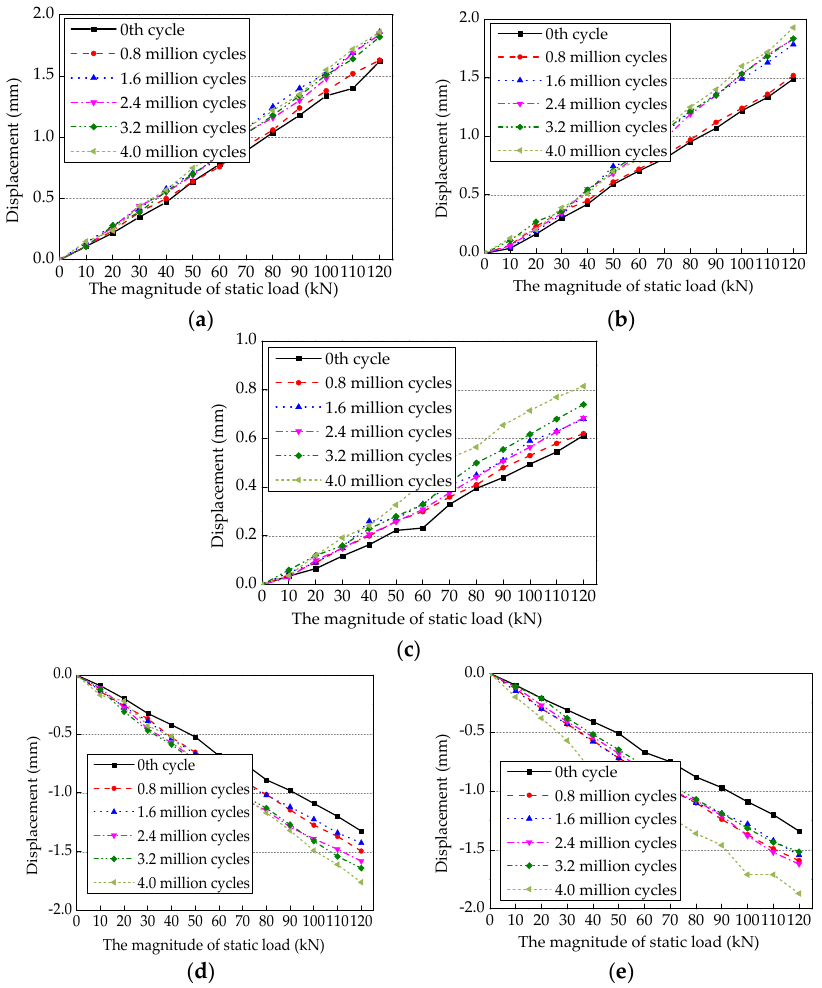
Figure 9. Effect of fatigue cycles on static load—displacement curves. ( a ) Measurement point DI1. ( b ) Measurement point DI7. ( c ) Measurement point DI4. ( d ) Measurement point DI3. ( e ) Measurement point DI5.